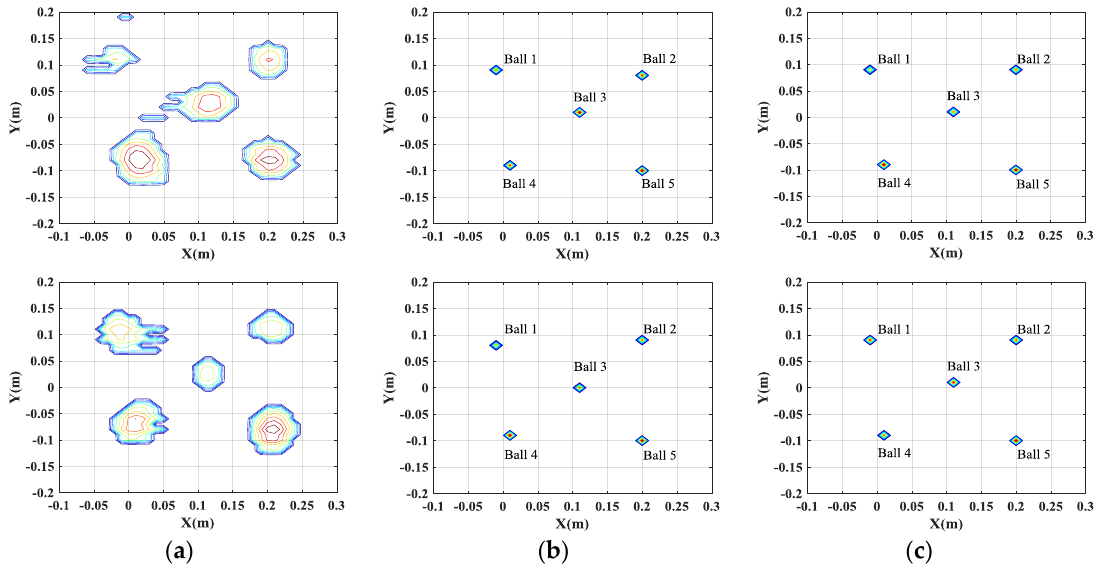
Figure 5. Comparison of imaging results by different imaging methods. Images in the first row are from the results of channel 1. Images in the second row are from the results of channel 2. ( a ) FBP method; ( b ) single channel CS method; and ( c ) multichannel joint CS method.